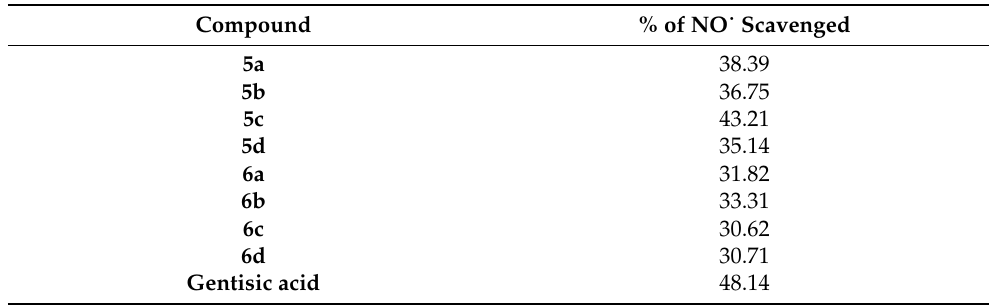
Table 3. Results of the NO˙ scavenging assay.